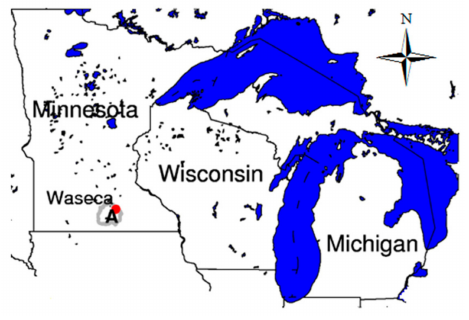
Figure 1. Great Lakes region states.